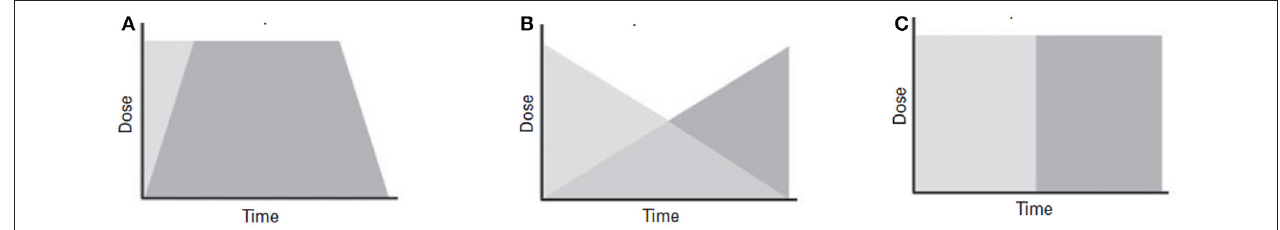
FIGURE 2 | Schematic diagrams of switching strategies. (A) Concurrent switch is best suited for patients demonstrating partial response, where simultaneous change in the dose of both medications is implemented. (B) Overlapping switch is suitable for patients who demonstrate partial response, where the dose of the original medication is maintained until the second medication reaches its optimal dose. (C) Sequential switch is considered to be the safest switching technique, as it is the least likely to cause any interaction. In this strategy, one medication is substituted with another. This technique is used in patients who do not respond to initial